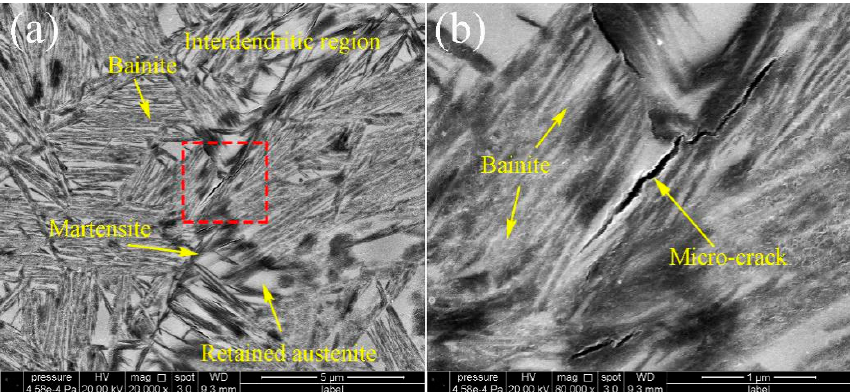
Figure 13. Typical tensile fractography of ( a ) the coatings obtained at 200 °C, and ( b ) the coatings obtained at 250 °C, and ( c ) the coatings obtained at 300 °C.